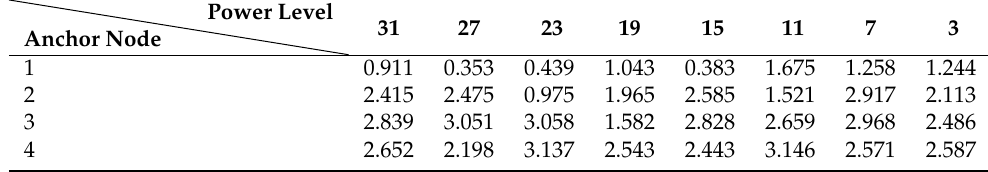
Table 3. Signal propagation exponent η of anchor